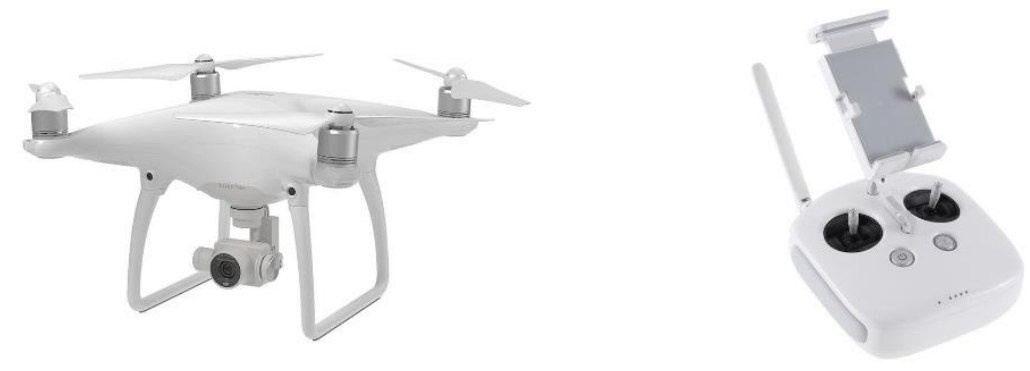
Figure 5. Unmanned aerial vehicle (UAV, commonly known as a drone) used in the present study (Phantom4, DJI).